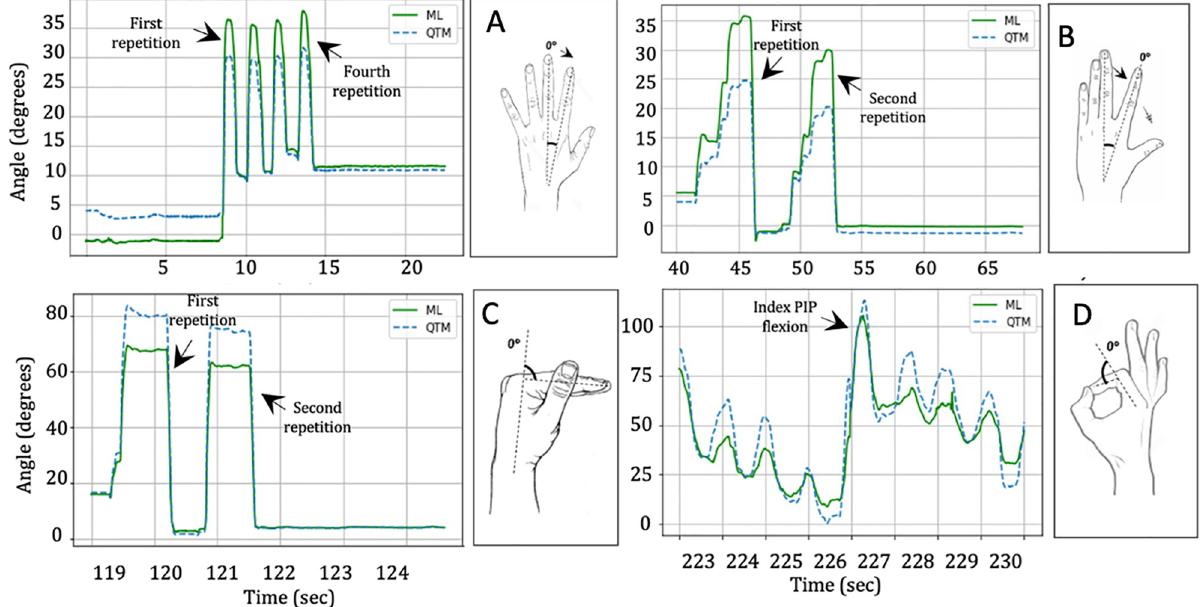
Fig 8. Examples of raw data for one healthy participant. Examples of averaged raw data for (A) 2nd-to-3rd digit angle for four repetitions of the abduction and adduction task, (B) 2nd-to-3rd finger angle for two repetitions of the radial walking task, (C) 2nd metacarpophalangeal (MCP) joint angle for two repetitions of the MCP flexion task, (D) 2nd proximal interphalangeal joint angle for the thumb opposition task, estimated using OpenPose (ML; solid lines) and measured with the optical motion capture system (QTM; dashed lines) for one representative healthy participant.